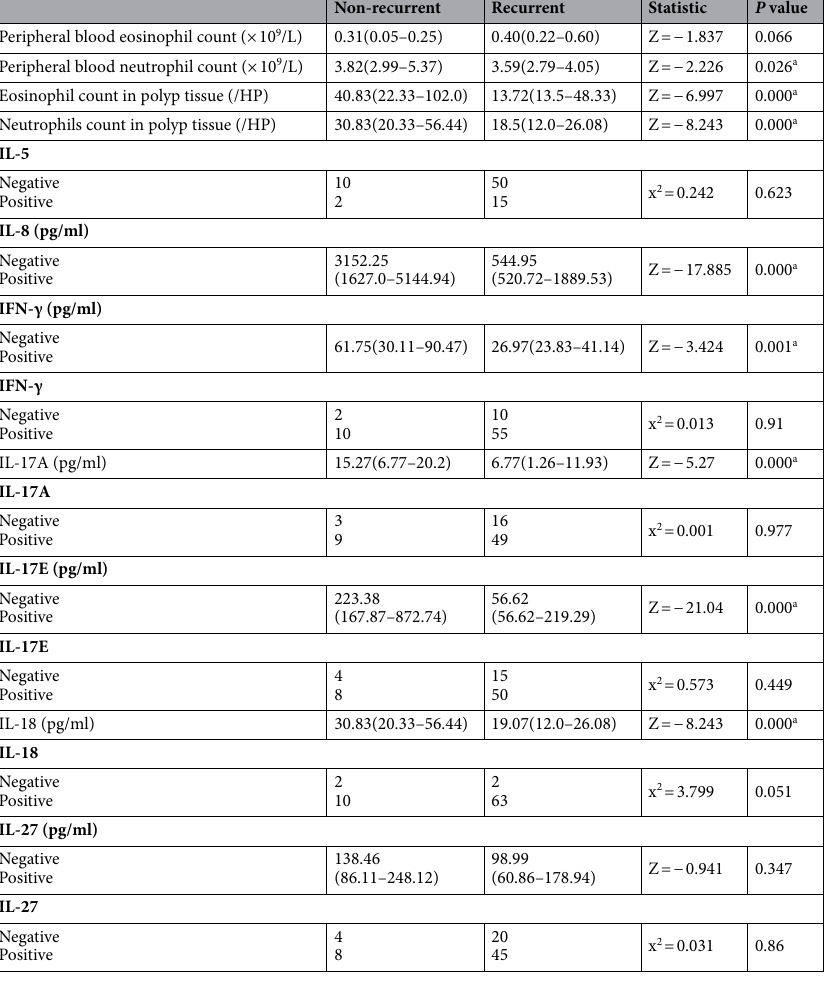
Table 2. Comparison of inflammatory mediators between recurrent and non-recurrent CRSwNP patients. a P <